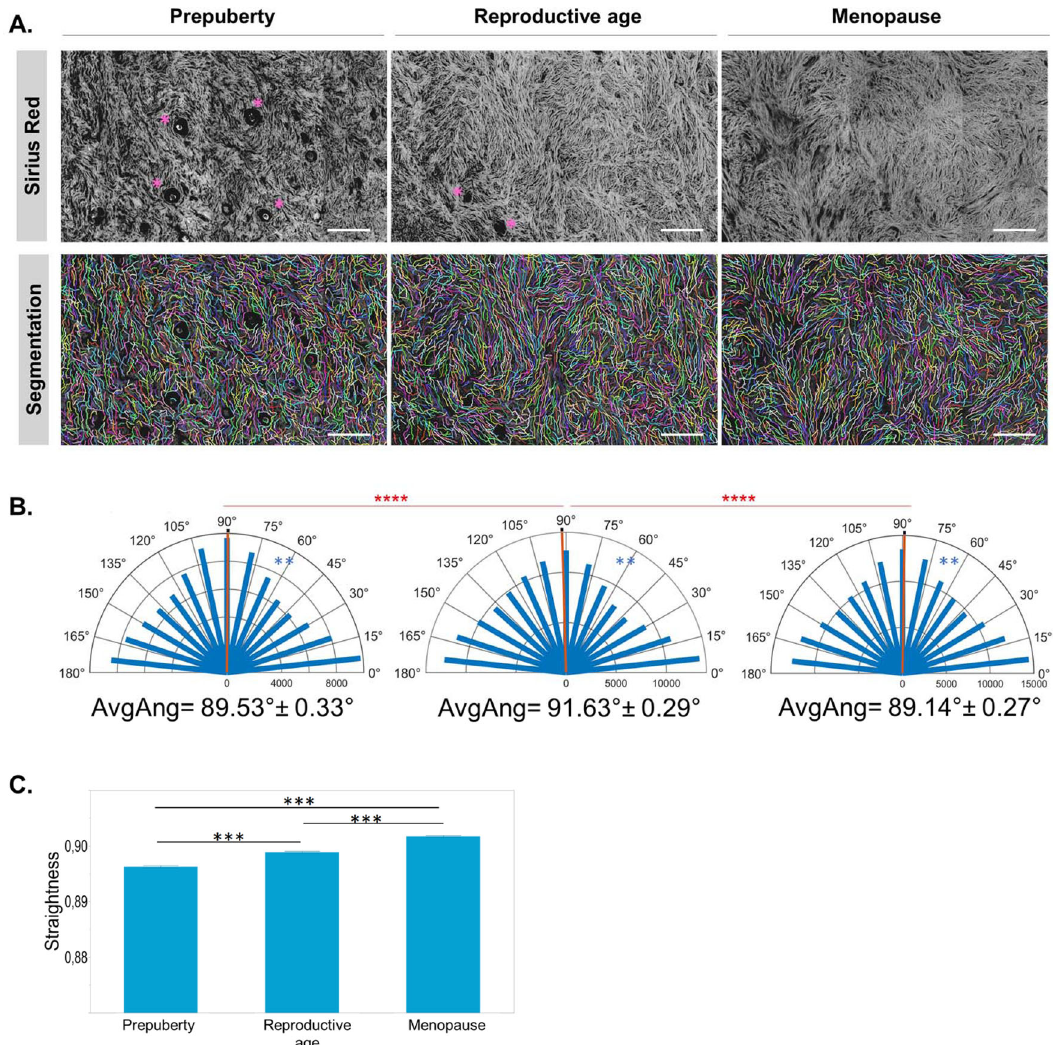
Fig. 3 Fiber orientation and straightness in the interstitial ECM. A Sirius Red-stained paraf fi n sections show collagen auto fl uorescence, which was used for collagen fi ber segmentation by curvelet transform that enabled measurement of directional fi ber distribution and fi ber straightness. Asterisks point to preantral follicles. B Angular fi ber distribution changes with age (blue) demonstrate the anisotropic nature of human ovarian tissue, but average angles change only at reproductive age (red), and no signi fi cant differences were noted between prepubertal and menopausal tissues. C Fiber straightness increases signi fi cantly with age ( n = 5 biologically independent samples/group). Straightness results were extracted from segmented and tracked fi bers as detailed in Table 1 and are expressed as mean ± SD. Statistical signi fi cance in fi ber straightness was obtained by one-way ANOVA followed by Tukey ’ s post hoc multiple comparisons. Three to fi ve regions per slide were selected from Sirius Red scans for fi ber orientation and straightness measurements. The Rayleigh test was applied to assess whether fi bers are uniformly oriented from 0° to 180° within each age group or display a common mean direction. The Watson ’ s parametric multiple sample test and Kuiper ’ s test with Bonferroni correction were applied to successively compare mean directions and directional distribution between study groups (** p < 0.01; *** p < 0.001; **** p < 0.0001). Scale: 100 µ